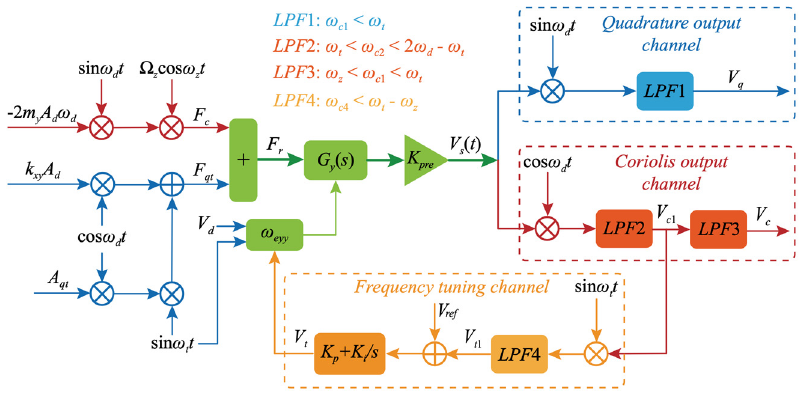
Figure 12. Control block diagram of the mode-matching algorithm based on quadrature modulation from Southeast University.